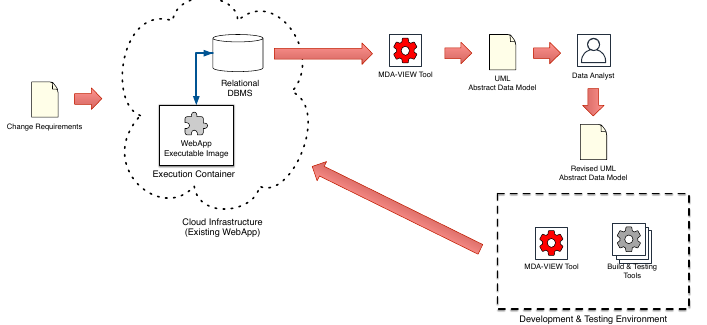
Figure 8. Change Request of an existing web application.